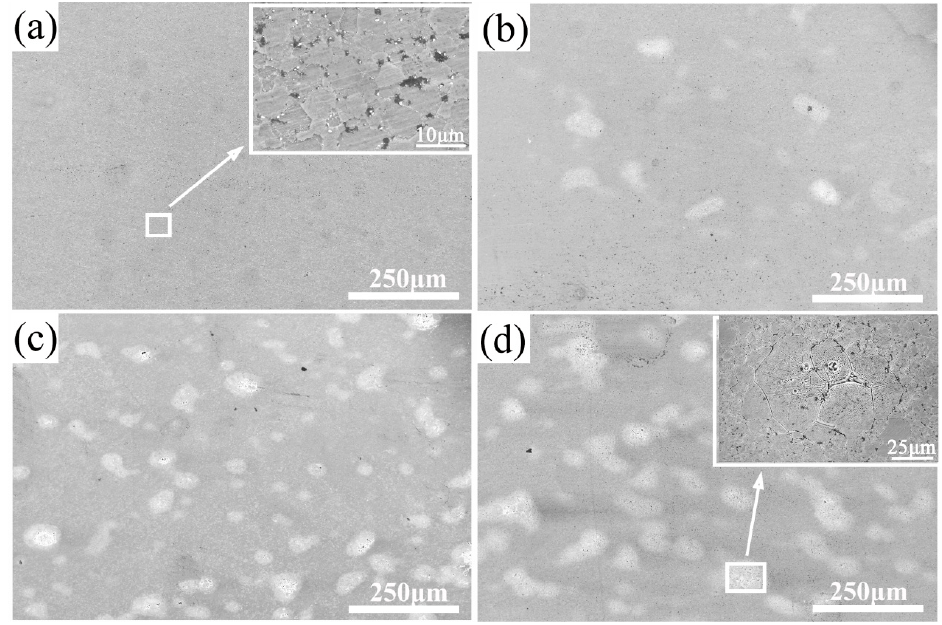
Figure 4. SEM images of NiAl-HEA composites after etched: ( a ) 0 wt.% HEA; ( b ) 5 wt.% HEA; ( c ) 10 wt.% HEA; and ( d ) 15 wt.% HEA.